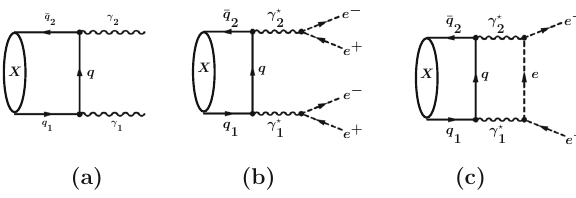
Fig. 34 Feynman diagrams of a QED meson decaying into a photon pair